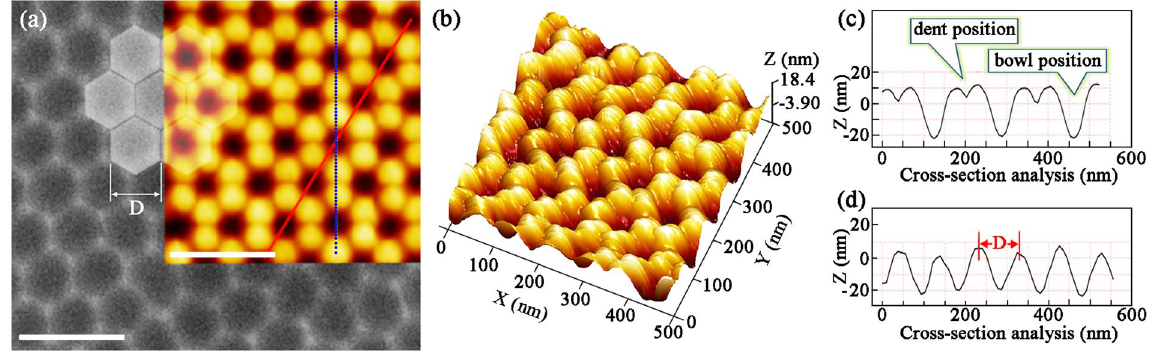
Figure 2. ( a ) A typical SEM image of Al nanobowl array ( V AAO = 40 V) and the inset is a 2D AFM image. The scale bars are both 200 nm. ( b ) 3D AFM image of the Al nanobowl array ( V AAO = 40 V). ( c,d ) Cross-section analysis along the dash and solid lines in the inset of ( a ),